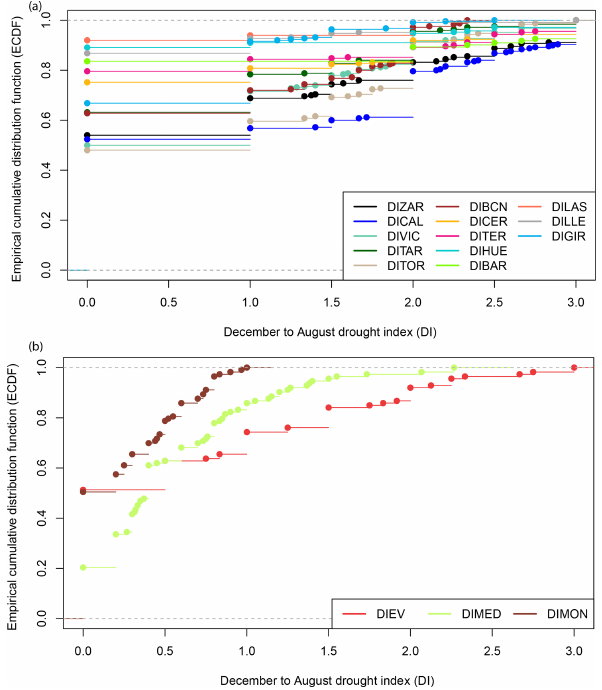
Figure 2. The empirical cumulative distribution function (ECDF) used to describe a sample of observations of a given variable. Its value at a given point is equal to the proportion of observations from the sample that are less than or equal to that point. ECDF analysis was performed for the local drought indices (a) and the regional drought indices (b) .